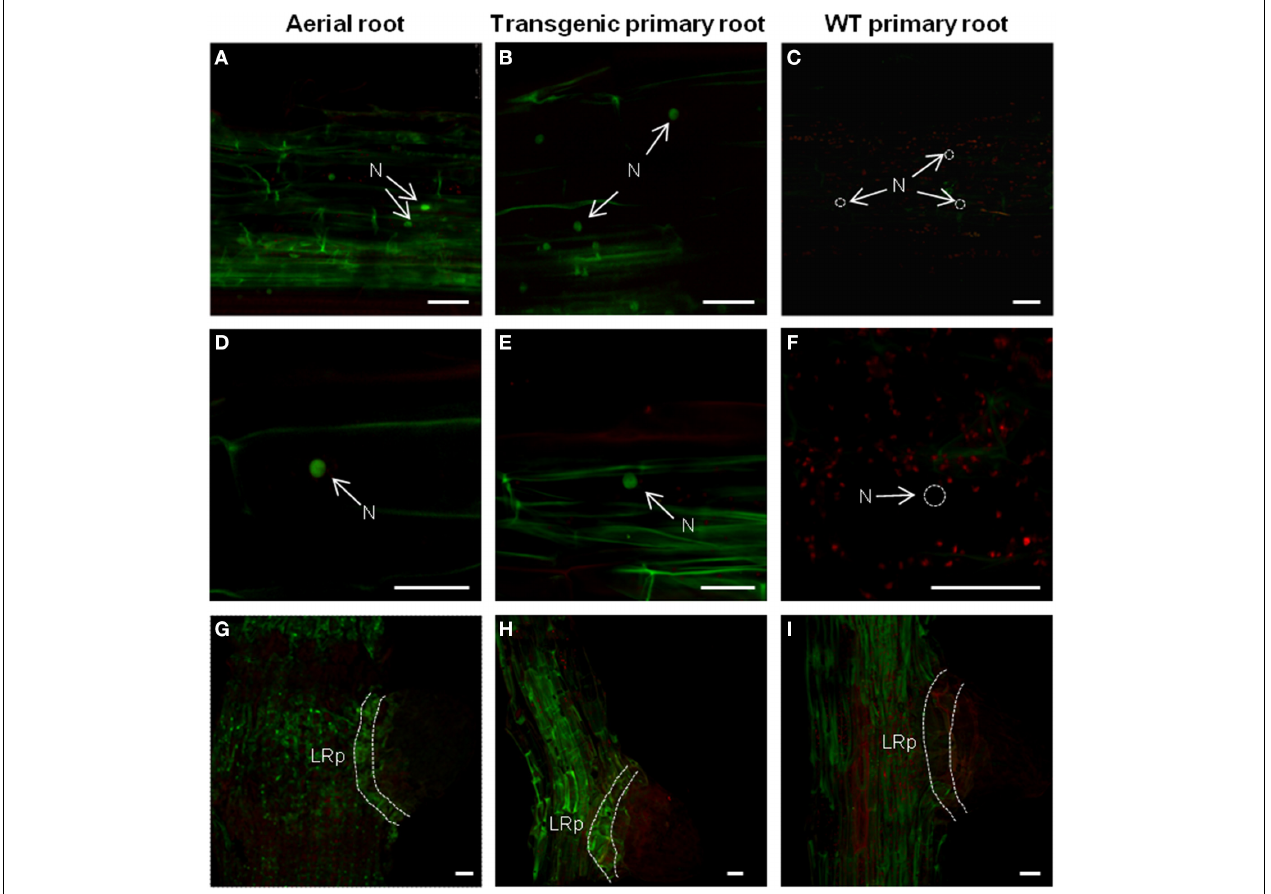
FIGURE 6 | Comparison of the protein localization pattern between adventitious and primary roots in heterografts. Mid-root region from aerial or primary roots were used to identify AtTCTP2-GFP signal through fluorescence confocal microscopy. AtTCTP2-GFP nuclear localization (N) in the mid-root region of (A,D) aerial and (B,E) transgenic